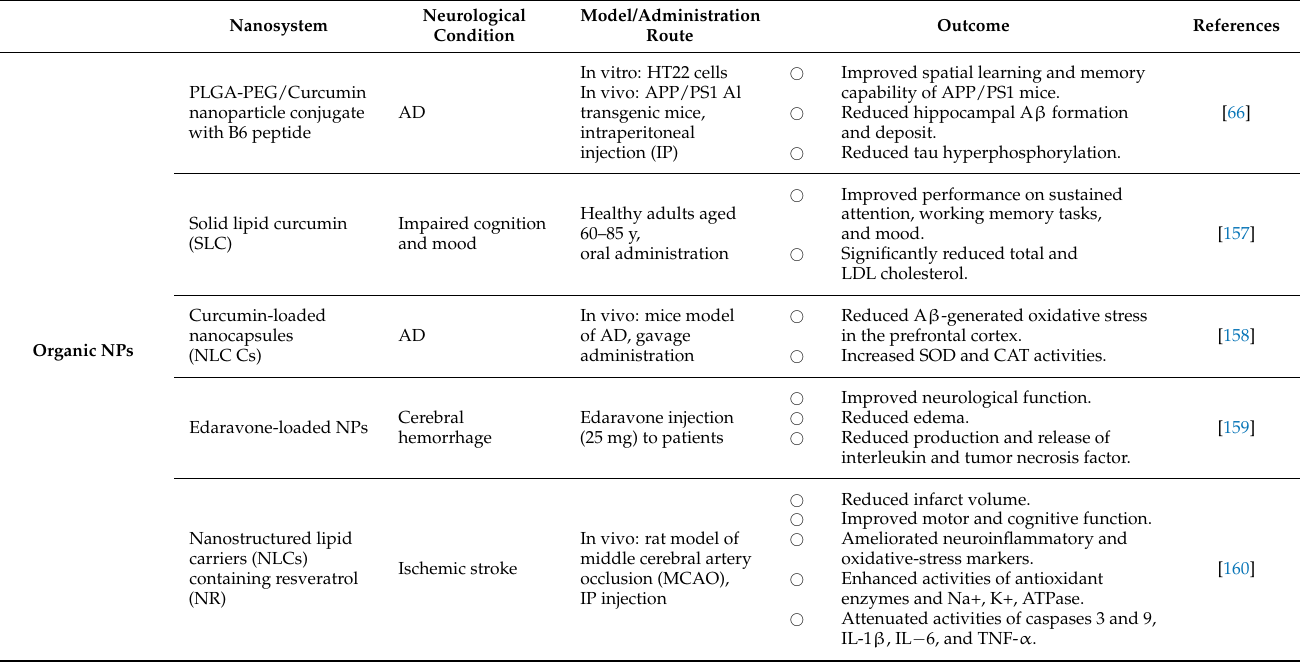
Table 1. Antioxidant-based nanoparticles and nanoconjugates with the potential to improve the neurological consequences of